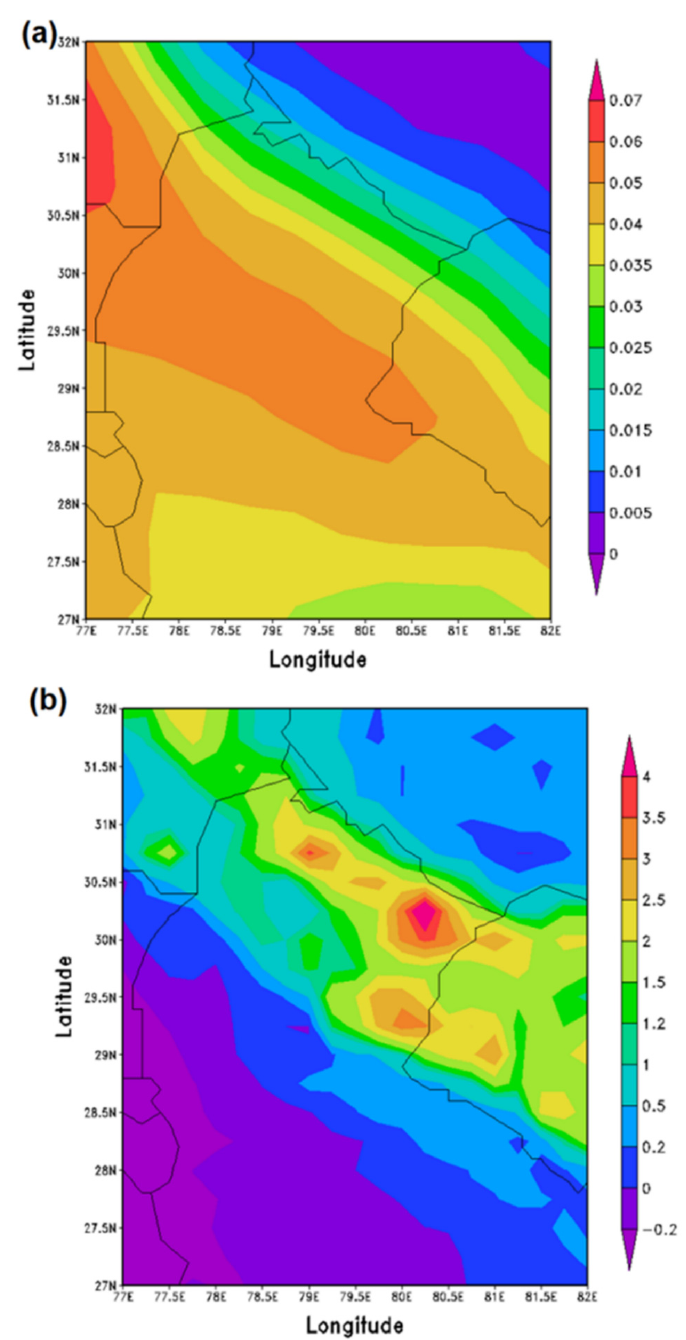
Figure 13. Spatial distribution of ( a ) LFR (flashes km − 2 day − 1 ); ( b ) proxy (kg m − 2 day − 1 ). Using this proxy for projecting the LFR over the small part of the study region of Srinagar, it is observed that the maximum similarity is observed between the proxy and LFR, as seen from the spatial distribution in Figure 12. Because of large changes in the